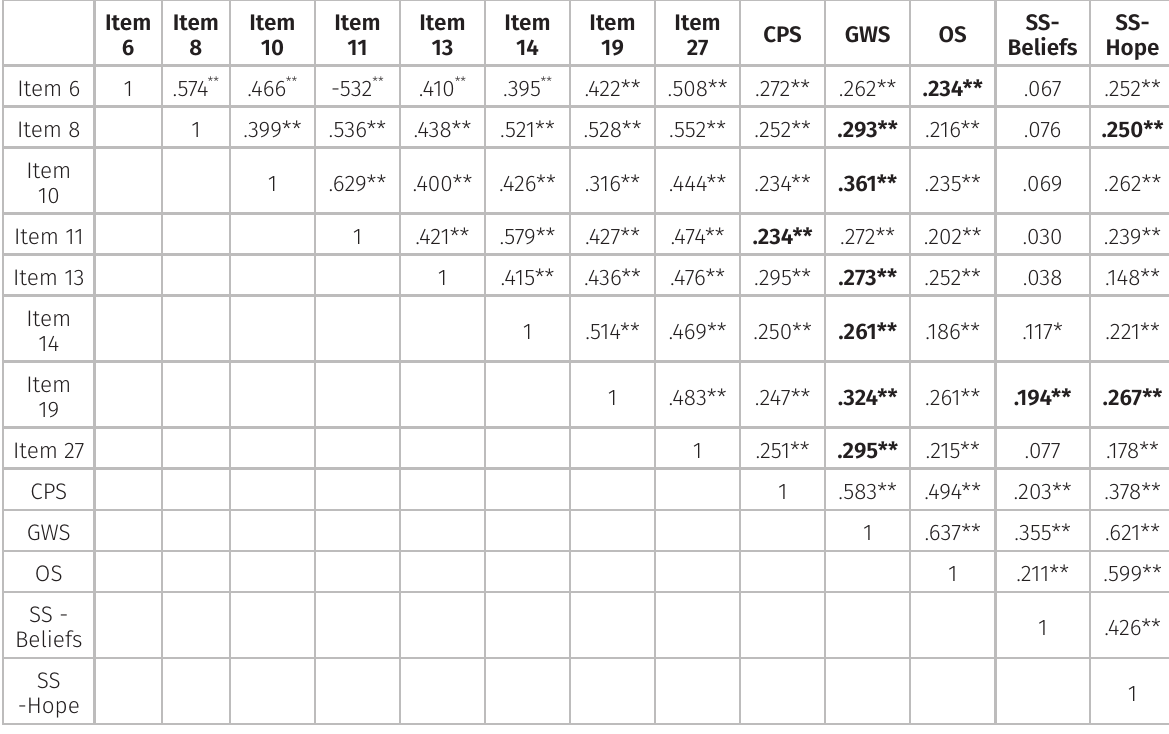
Table II. Pearson correlation for convergent validity.